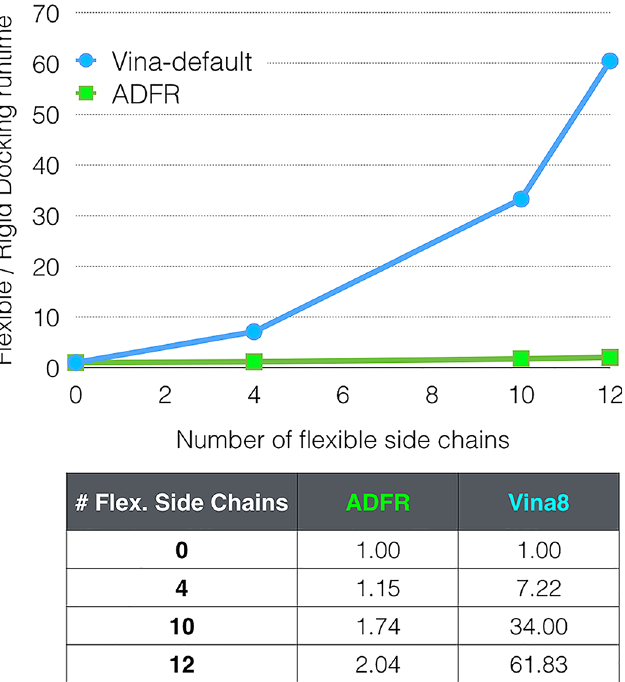
Fig 6. Scaling of docking runtimes as function of the number of flexible receptor side-chains. The Y- axis represents multiples of the rigid cross-docking runtimes. The times used in this graph are averages taken over all docking runs for the 52 complexes of the CDK2 cross-docking experiments. For AutoDock Vina the times corresponding to the default exhaustiveness 8 are used. The X-axis indicates the number of flexible receptor side-chains. ADFR scales by a factor of 2, while Vina 8 scales by a factor of 62, when 12 protein side- chains are made